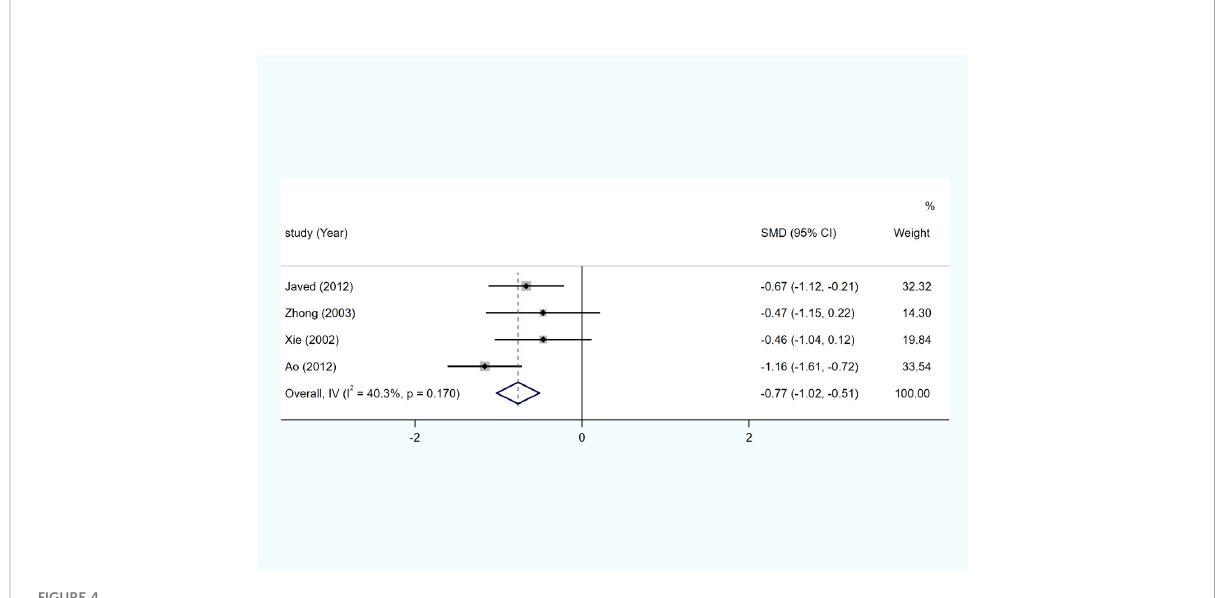
FIGURE 4 Forest plot for the results of dysphagia scores.